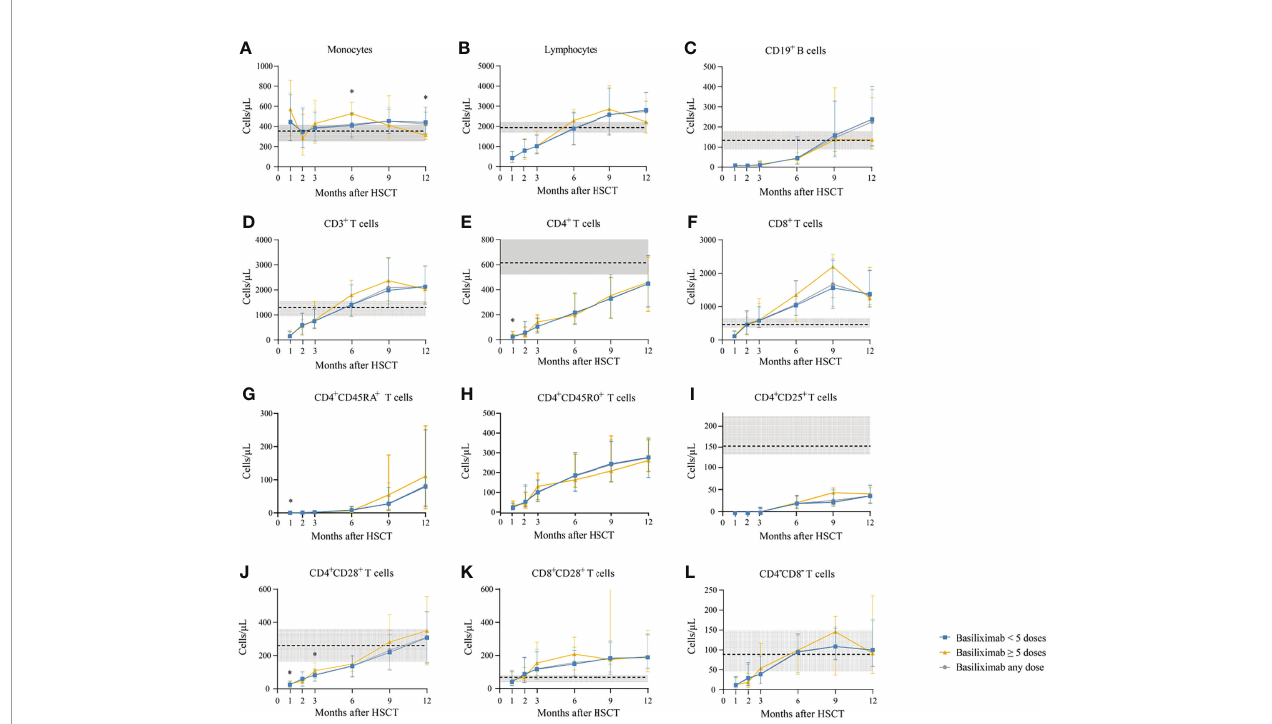
FIGURE 2 | (A-L) Kinetics of immune reconstitution in the total population that showed an ORR after basiliximab treatment. Immune cell subsets are compared between basiliximab <5 doses and basiliximab ≥ 5 doses. Because of lack of data about CD4 + CD45RA + T cells and CD4 + CD45RO + T cells in healthy donors, the values of these two immune cell subsets in healthy donors are not shown. Data are shown as median absolute counts with error bars indicating the 25th – 75th percentiles. The horizontal dotted lines represent the median value of healthy cohorts, and the gray areas represent the 25th – 75th percentiles for the healthy